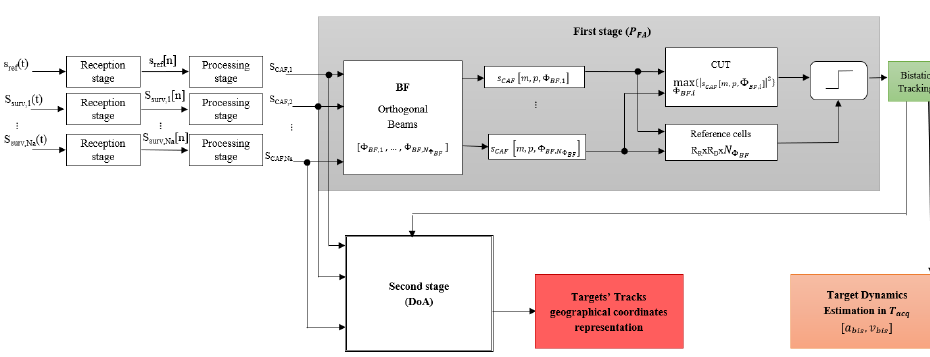
Figure 6. IDEPAR array signal processing processing scheme